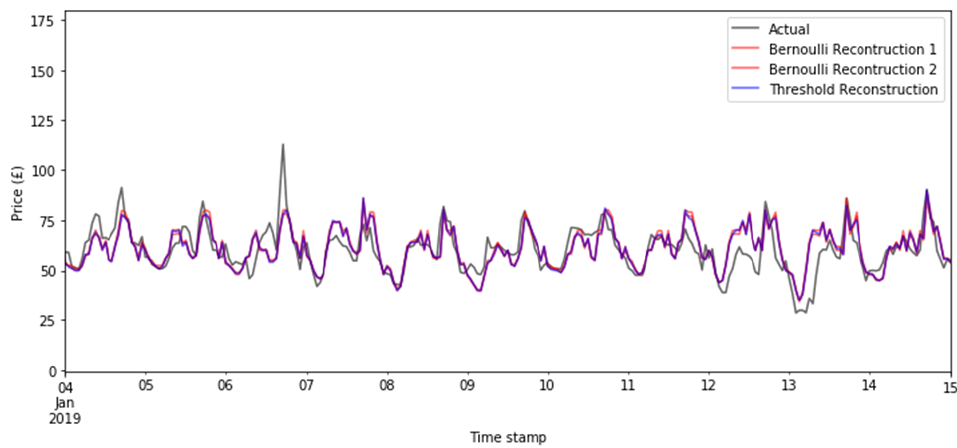
Figure 15. Reconstructed day-ahead forecasts for prices with the fixed threshold method (i.e., the point forecast in blue) and two Bernoulli random draws (red) for selected days in the test set. These are compared to the actual prices